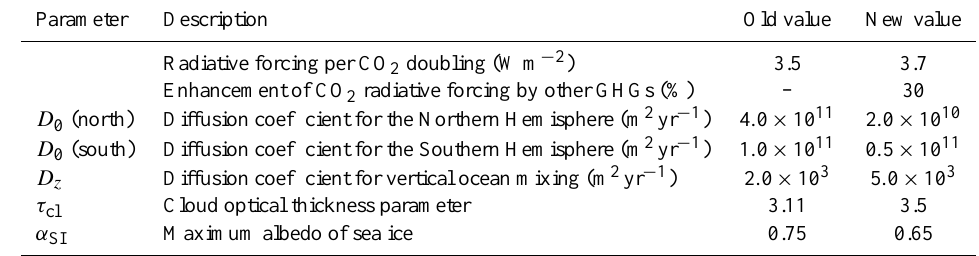
Table 1. Model parameters for the ZEBCM, altered in this study (new value) with respect to Bintanja (1997) (old value).